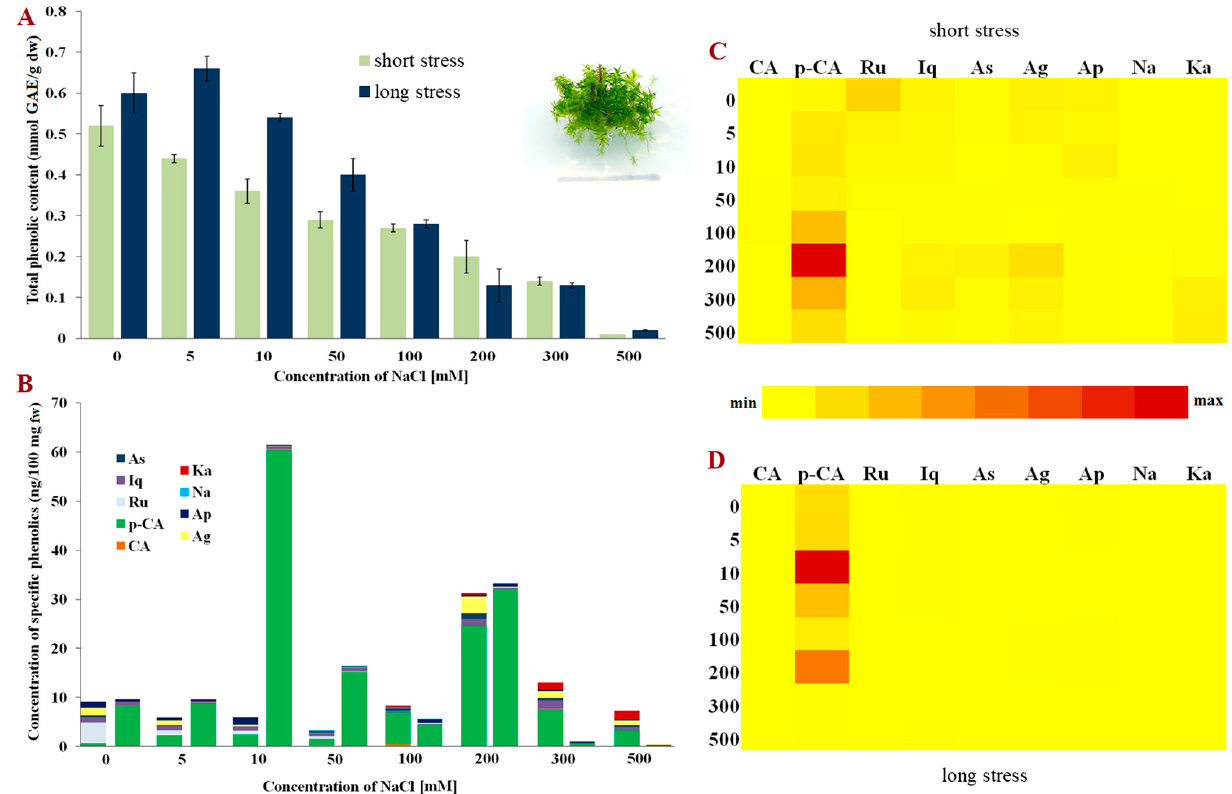
Figure 2. Phenolic content in Entosthodon hungaricus . ( A ) Total phenolic content in short- and long-term stress; ( B ) Content of phenolic compounds; ( C ) Relative representation of phenolic compounds in short-term stress; ( D ) Relative representation of phenolic compounds in long-term stress. Abbreviations: astragalin (As), isoquercitrin (Iq), rutin (Ru), p-coumaric acid (p-CA), caffeic acid (CA), kaempferol (Ka), naringenin (Na), apigetrin (Ap), apigenin (Ag), gallic acid (GAE), fresh weight (fw) and dry weight (dw).